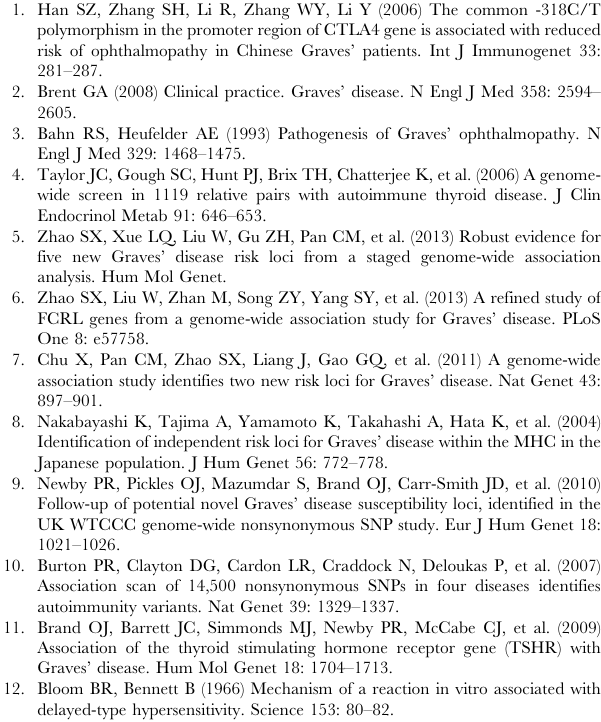
Table S1 Characteristics of in the subgroups of patients with Graves disease. Table S2 Distributions of alleles and genotypes of the MIF polymorphisms with respect to the severity of goiter in patients with euthyroid Graves disease. Table S3 Distributions of alleles and genotypes of the MIF polymorphisms with respect to the severity of goiter in patients with treated Graves disease. Table S4 Gender effects on distributions of alleles and genotypes of the MIF polymorphisms with respect to the severity of goiter in patients with untreated Graves disease. Table S5 Clinical Significance of MIF Genotype in patients with euthyroid and untreated Graves